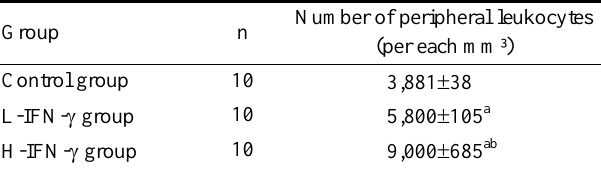
Figure 2. Effect of IFN-  on IL-18 Expression in peripheral blood of pregnant rats. ** p<0.05, ** p<0.01.